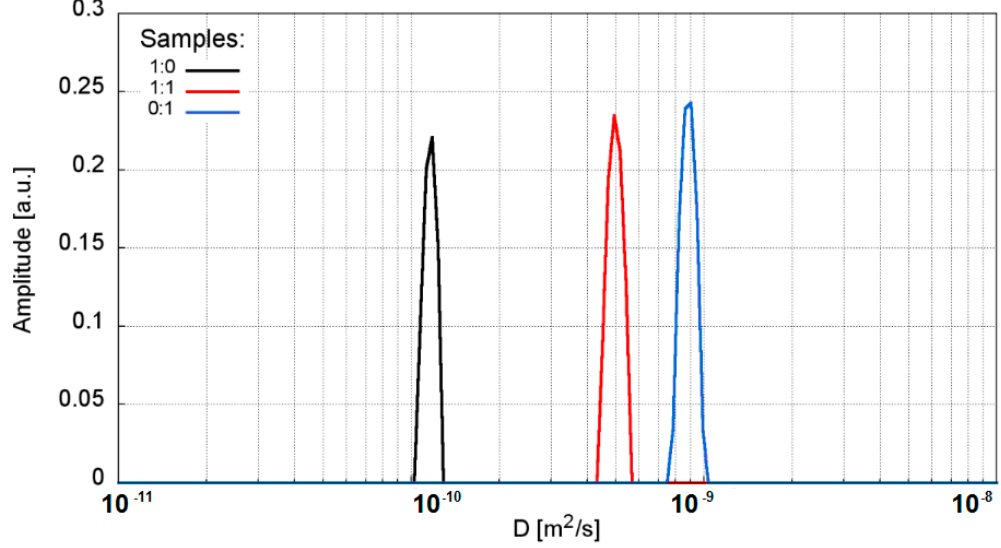
Figure 9. Diffusion coefficient distributions for the selected samples: sodium water glass R-150 (1:0), polymer-silicate hydrogel of the 1:1 mass ratio (1:1), cross-linked sodium polyacrylate (0:1).